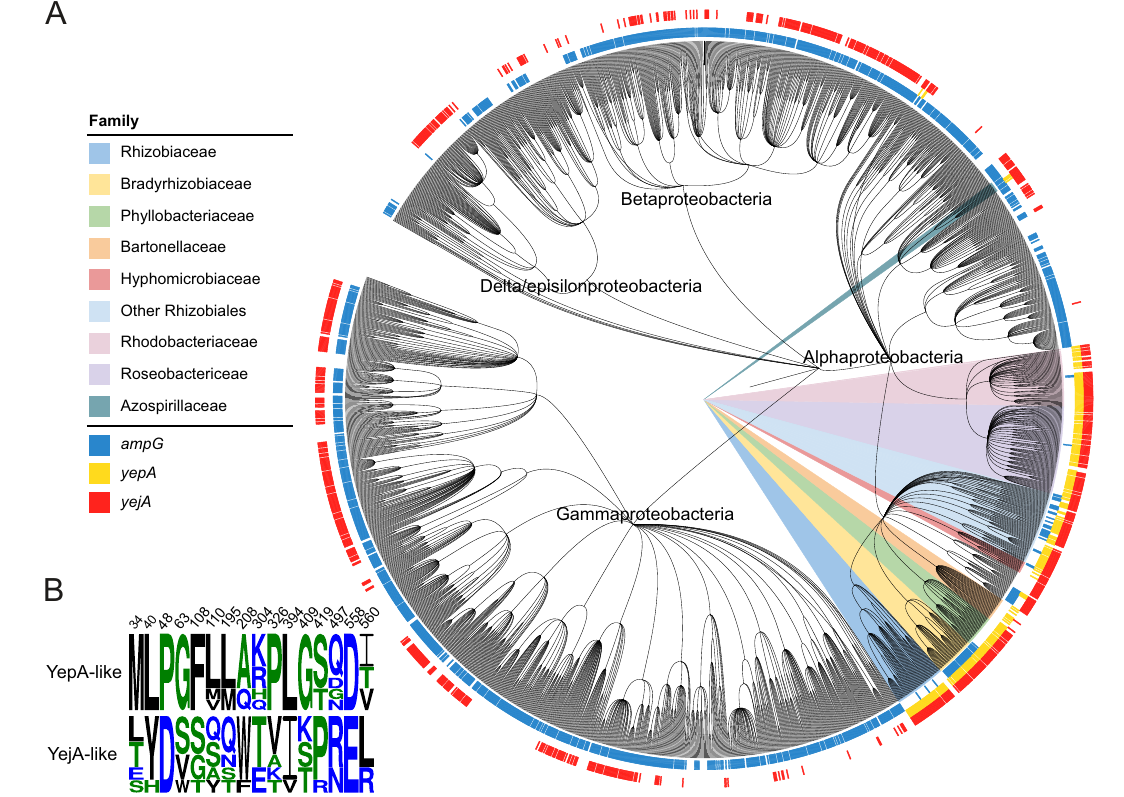
Fig.5|YejABEFiswidespreadintheproteobacteria,butYepAisonlypresentintheAlphaproteobacteria.A Phylogenetictreeshowingdistributionof ampG , yejA and yepA in the Proteobacteria. B Molecular fi ngerprint residues of YepA used to differentiate between YejA and